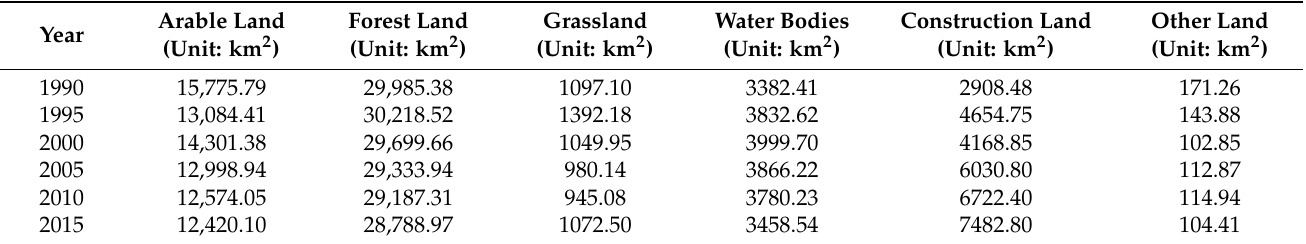
Table 1. Change trends of different land use in the Pearl River Delta from 1990 to 2015.